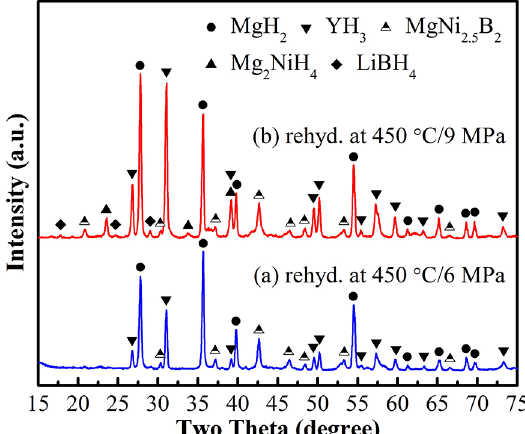
/Mg YNi-H composite after 4 10